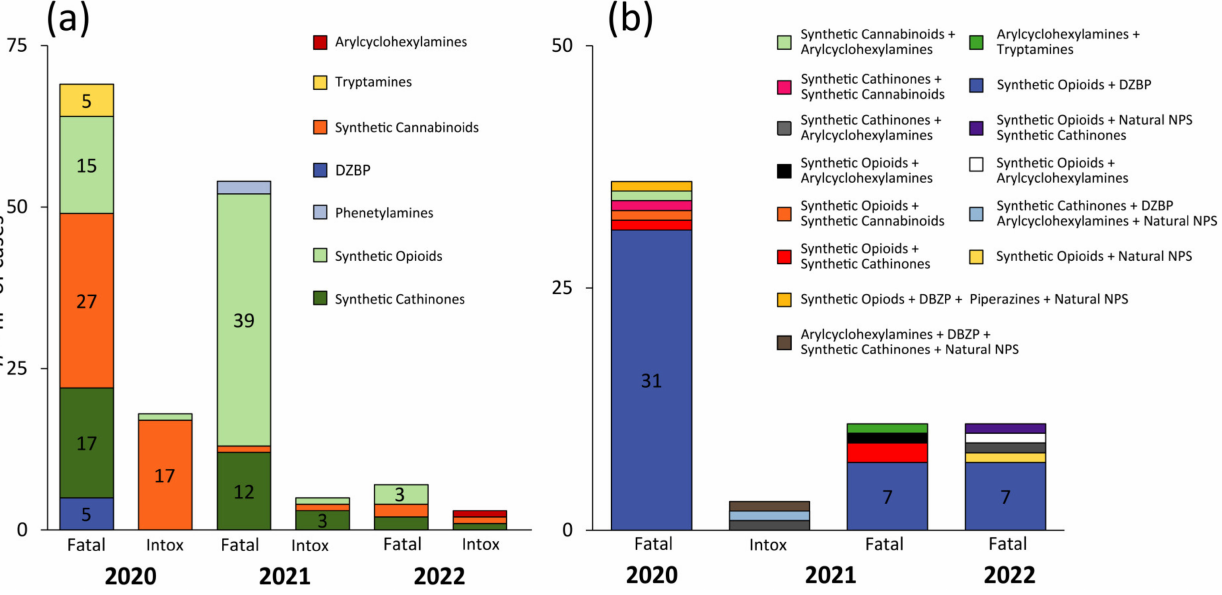
Figure 4. ( a ) Number of NPS single intoxications and fatalities cases; ( b ) NPS mixed